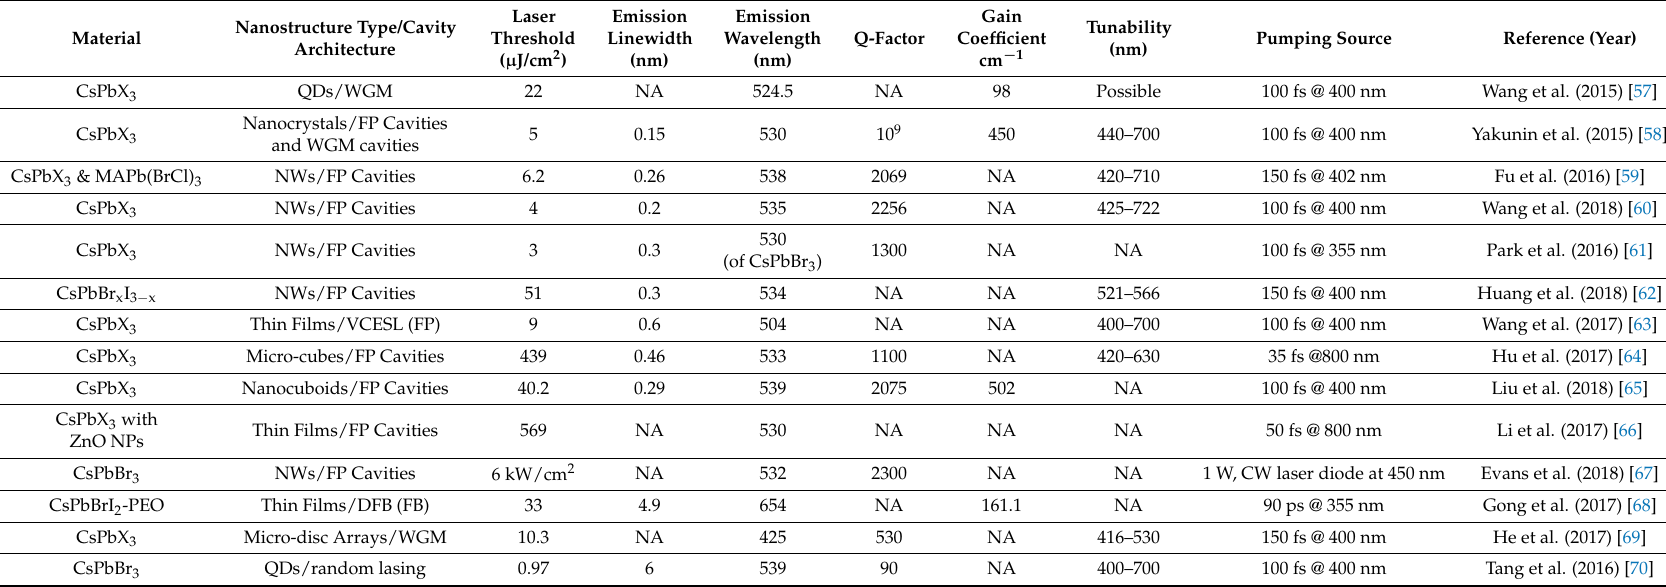
Table 2. Inorganic Perovskite Based Laser Device Characteristics; NA denotes for the Non-Available